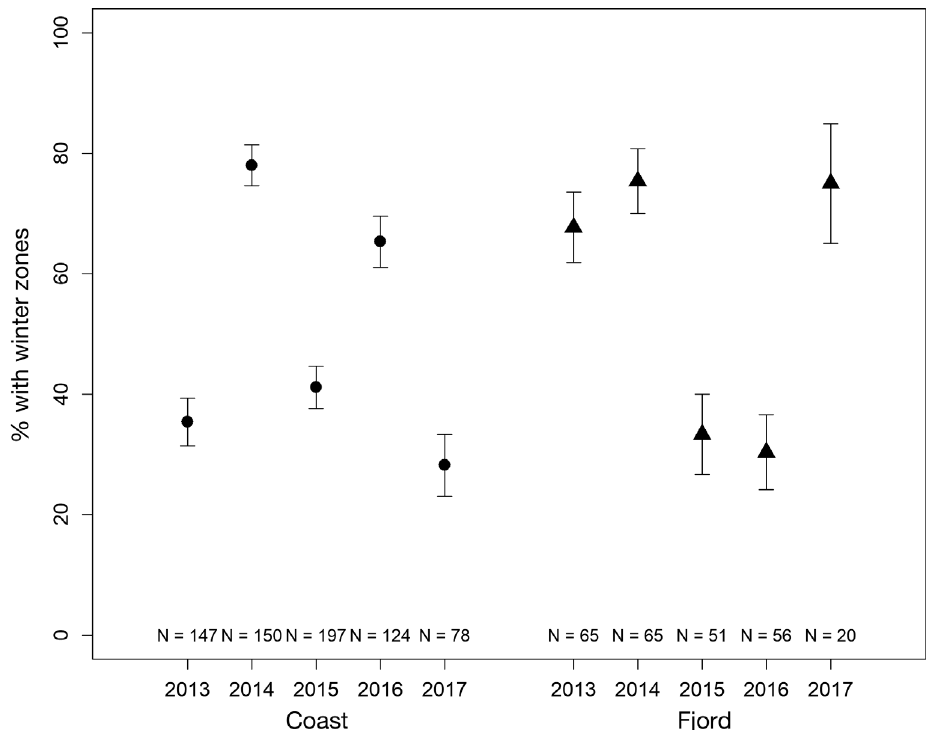
Fig. 6. Mean (±SE) percentage of individuals with 1 or more winter zones after escape on the coast and in the fjord from 2013 to 2017. The number of escapees with sufficient sample quality to analyze the number of winter zones in the growth pattern is given on the graph for both locations in each year national salmon fjord (Fig. 1), and there was no dif- ference between the coast and the fjord in the pro- portion of farmed salmon that escaped at a size ≤300 mm. This indicates that relatively few farmed salmon escaped as smolts/post-smolts in our study area be - tween 2013 and 2017. The proportion of farmed salmon showing one or more winter zones after escape in their scales also Table 2. Sample size (N) and mean (±SE) proportion of indi- viduals with 1 or more winter zones after escape of adult farmed salmon caught on the coast and in the fjord from 2013 to Locality